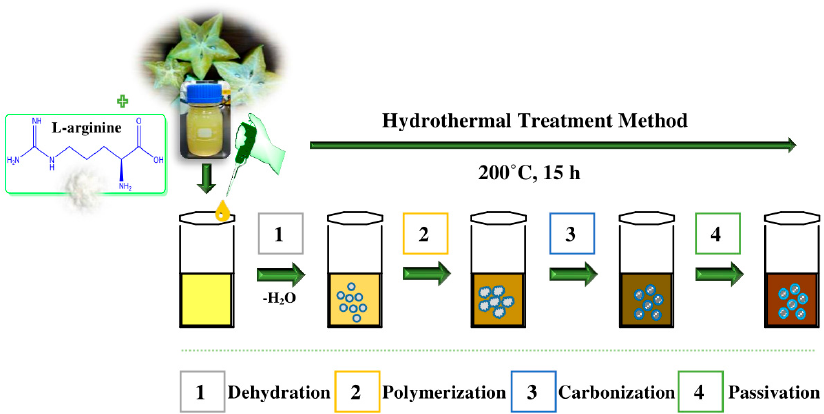
Figure 2. A proposed formation mechanism of AC-NCDs.